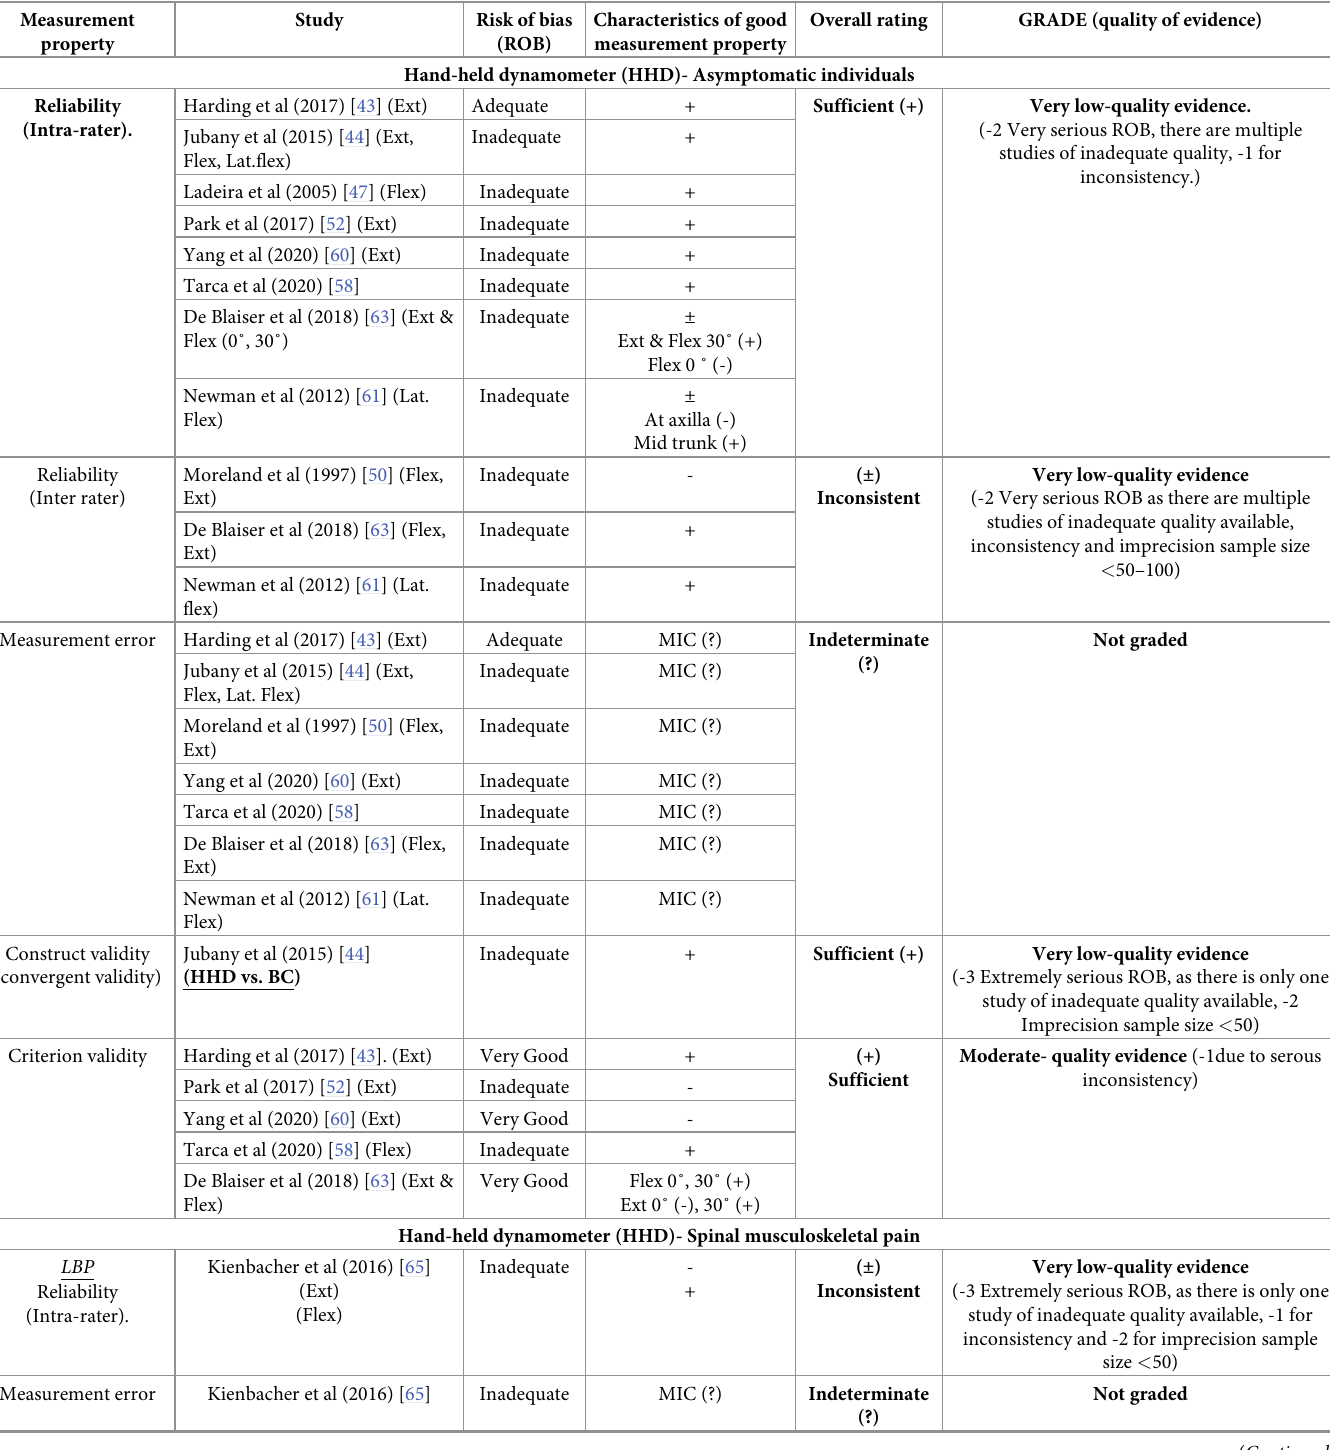
Table 3. Summary of risk of bias, criteria for good measurement properties and overall quality of evidence (GRADE). Measurement